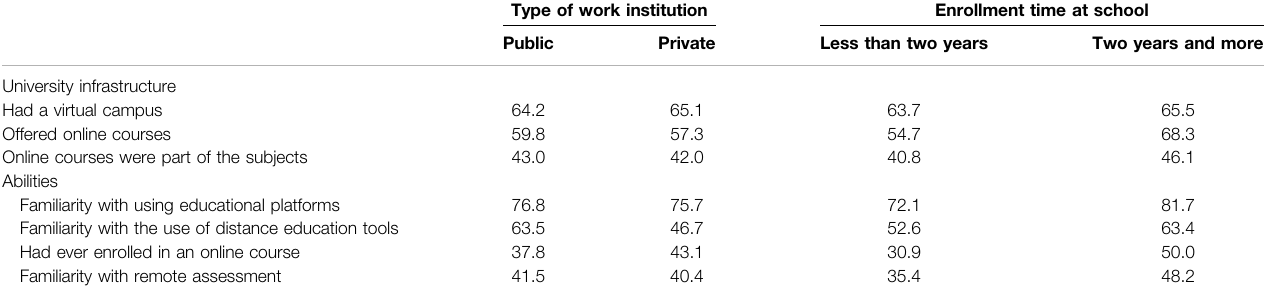
TABLE 4| Digital conditions ofthe students ’ institutionsand skillsbeforethe changefrom themodel toremote teaching, bytype ofinstitution and enrollmenttime at school.